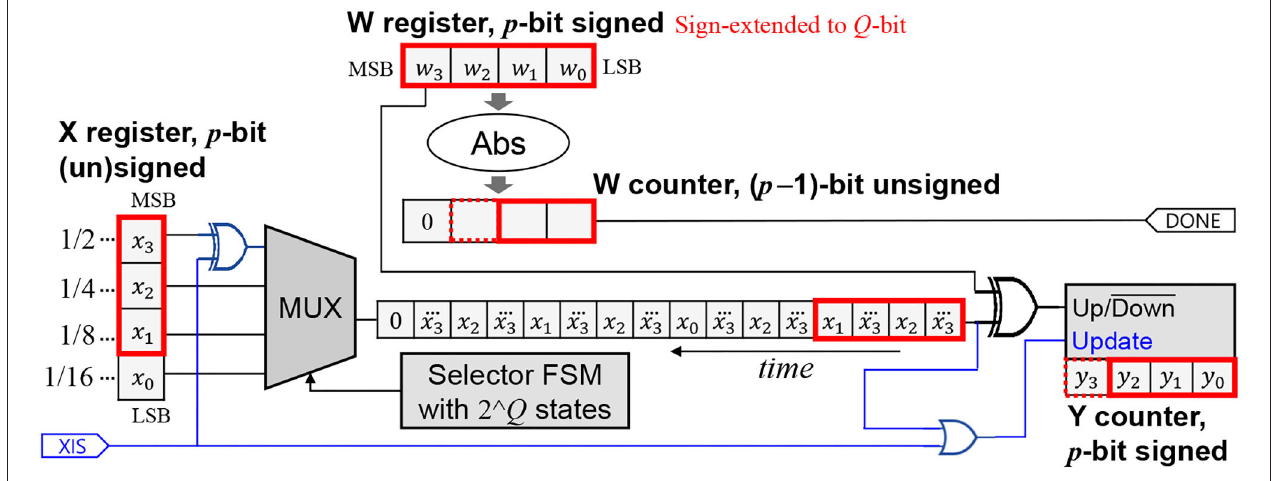
FIGURE 4 | Supporting HRS mode for x along with the normal mode. Extension is shown in blue. The new input XIS indicates whether x is signed.